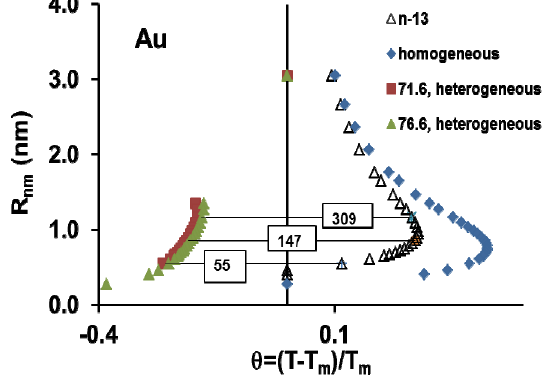
Figure 16. Supercooling temperatures of liquid gold depending on sample volume and controlled by unmelted superclusters having melting temperatures depending on overheating rate applied during 600